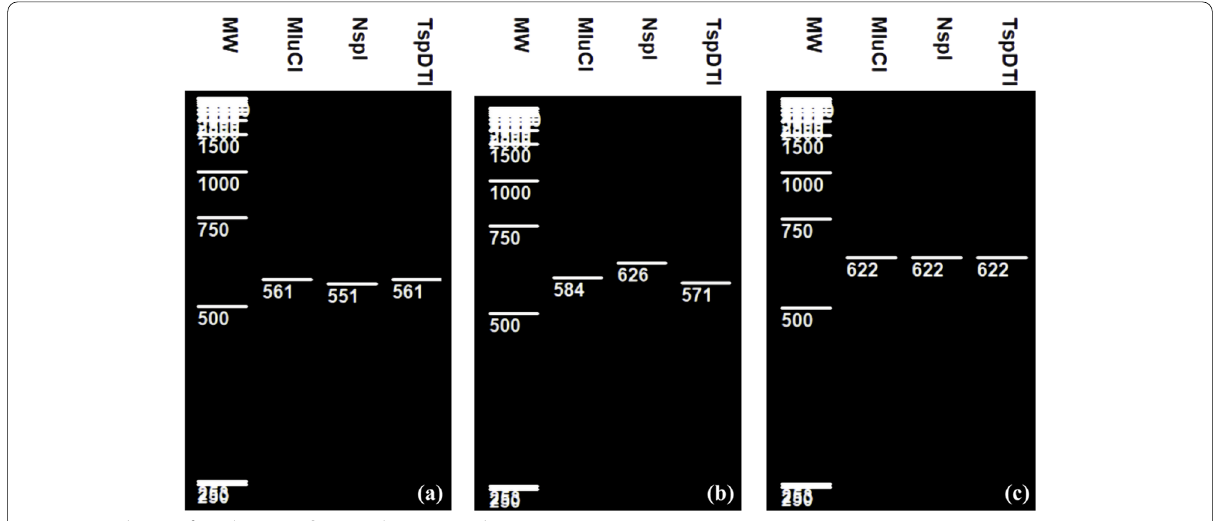
Fig. 3 Virtual RFLP of a Lplantarum , b Lparaplantarum and c L